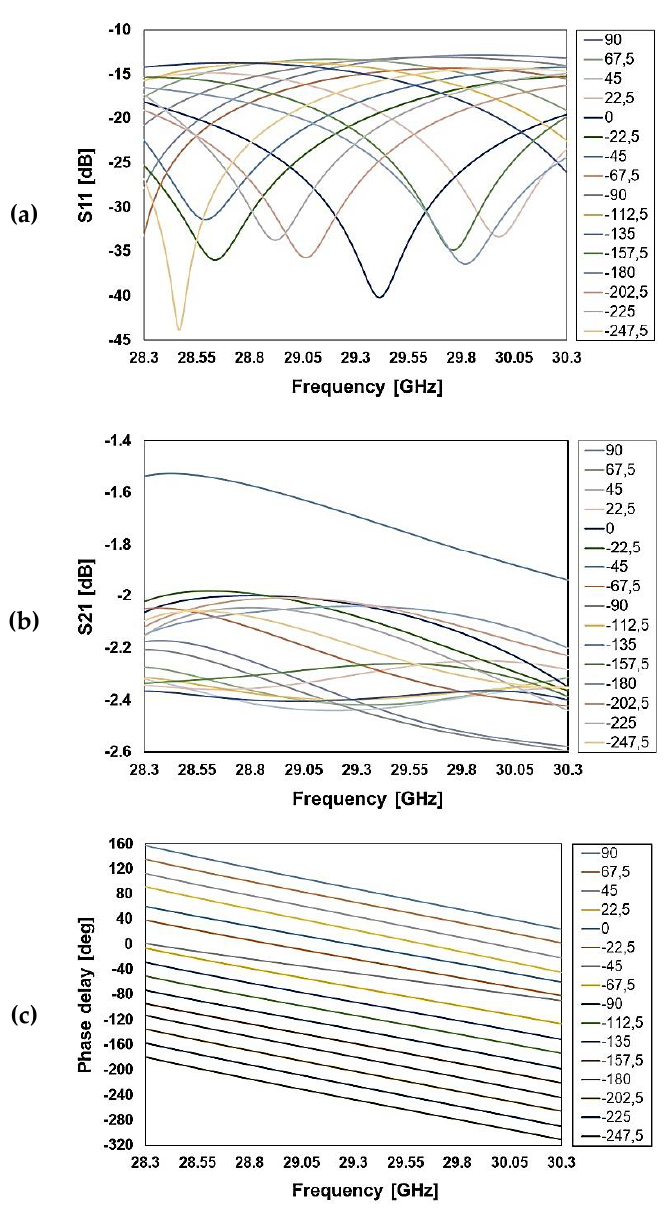
Figure 5. Simulated reflection ( a ), transmission ( b ), and phase shift ( c ) for several configurations of the Ka band RF-MEMS reconfigurable phase shifter (center frequency at 29.3 GHz).